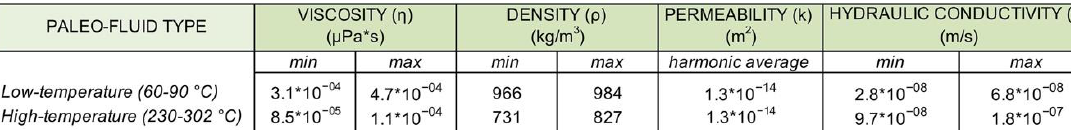
Figure 16. Minimum and maximum values of fluid density and viscosity, and of permeability and hydraulic conductivity considering early, high-temperature, and late low-temperature paleo-fluids, as based on the parameters obtained by field and laboratory analyses (after Reference [13]). Low-temperature data derive from fluid inclusions in calcite, whereas high-temperature data are from fluid inclusions analyzed in quartz. Both quartz and calcite were collected in the field and can be considered as representative of the main hydrothermal mineralizations recognized in the study area. The asterisk indicates the multiplication sign.